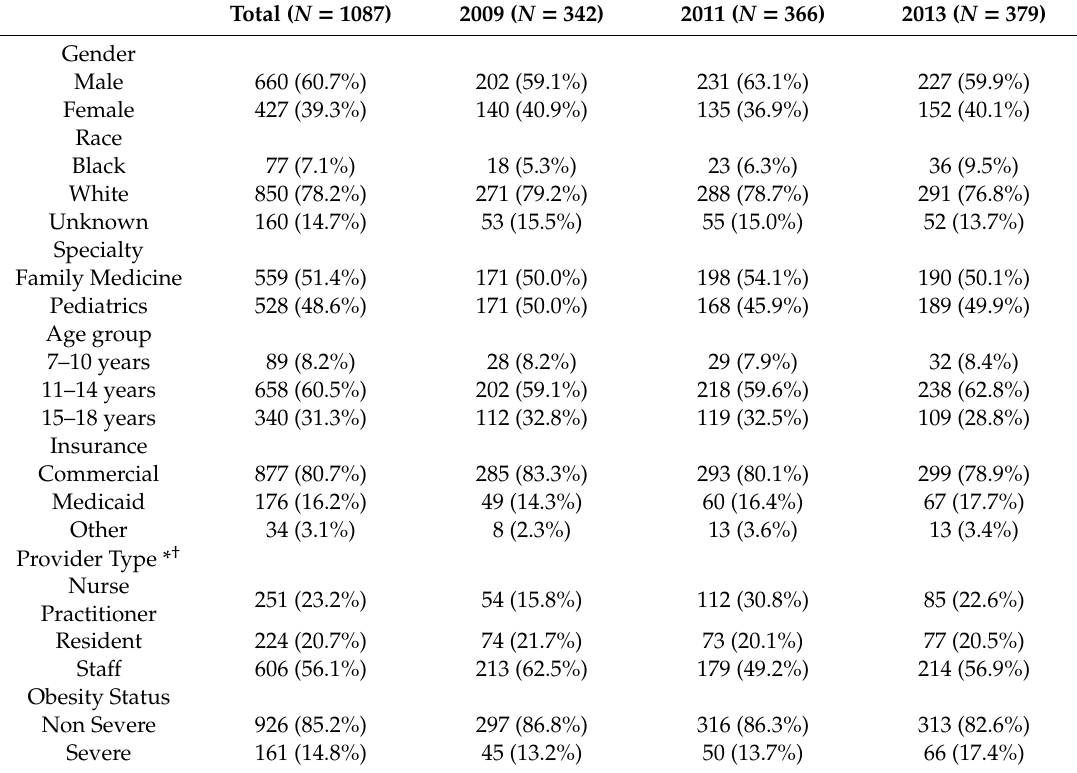
Table 1. Descriptive characteristics of study